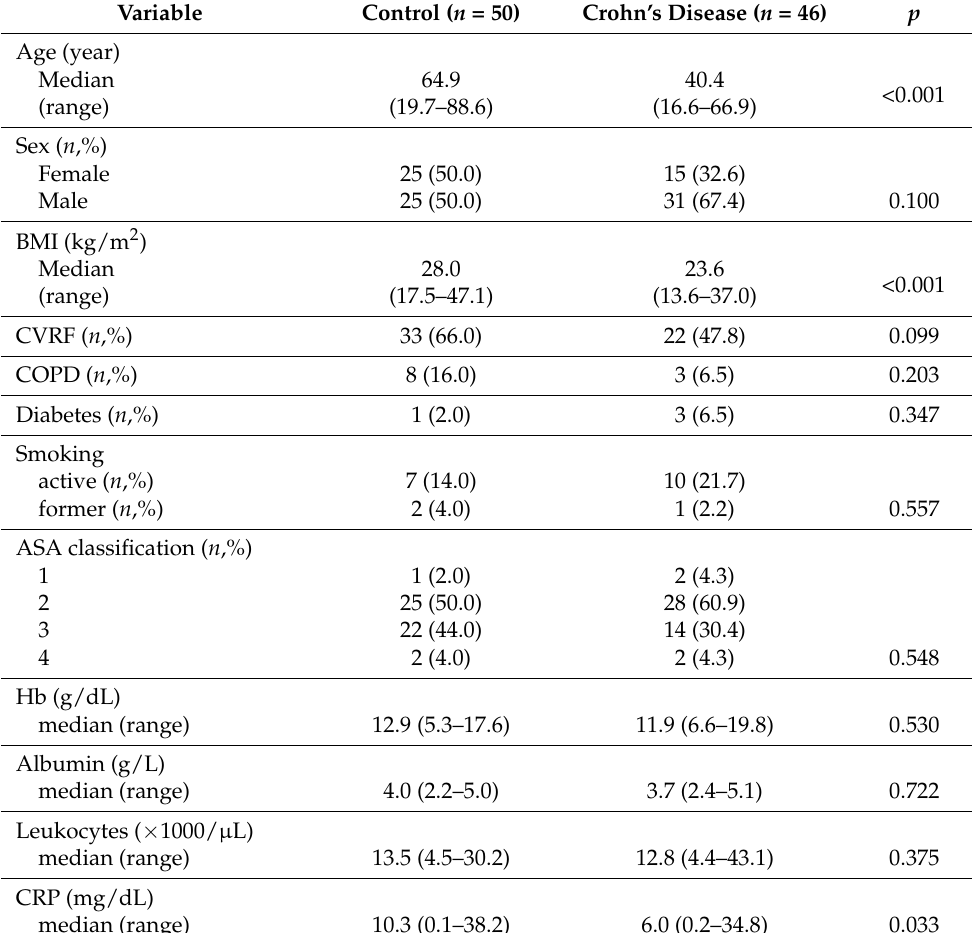
Table 1. Patient